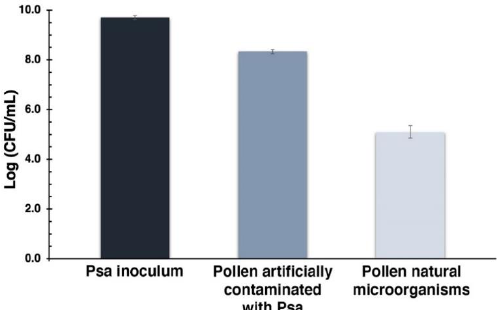
Figure 9. Efficiency of artificial pollen contamination with Psa. The first bar represents the Psa inoculum used to contaminate the pollen; the bar in the middle represents the total contamination achieved; the last bar corresponds to the pollen natural microorganisms. Values represent the mean of three independent assays in triplicate; error bars represent the standard deviation.